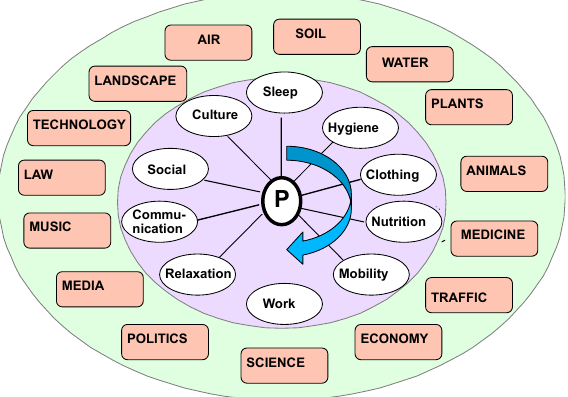
Figure 4. Lifestyle as a system of human–environment relations on a micro-level referred to a daily lifecycle and embedded in macro-level life conditions: From morning hygiene to dressing, nutrition, mobility, and work life over leisure time based social relations communication, and real social life to final cultural issues and health related issues of domain-specific lifestyles are to be considered. This framework helps therapists to design a multi-professional lifestyle related treatment plan for the person.